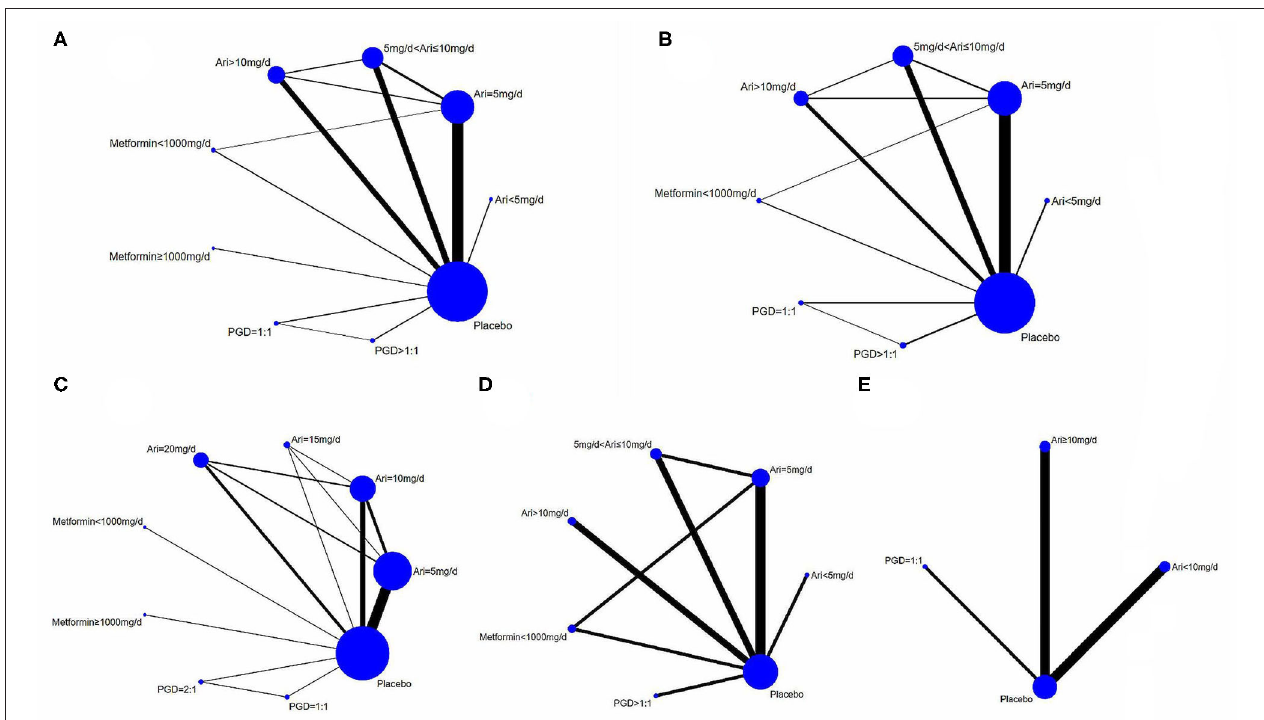
FIGURE 2 | Direct comparison of adjunctive aripiprazole, metformin and PGD in the treatment of hyperprolactinemia for schizophrenic patients. (A) Direct comparisons of adjunctive aripiprazole, metformin and PGD for reducing prolactin levels with all primary antipsychotics. (B) Direct comparisons of adjunctive aripiprazole, metformin and PGD in PANSS score changes with all primary antipsychotics. (C–E) Direct comparisons of adjunctive aripiprazole, metformin and PGD for reducing prolactin levels when using risperidone, amisulpride and olanzapine respectively as primary antipsychotics,